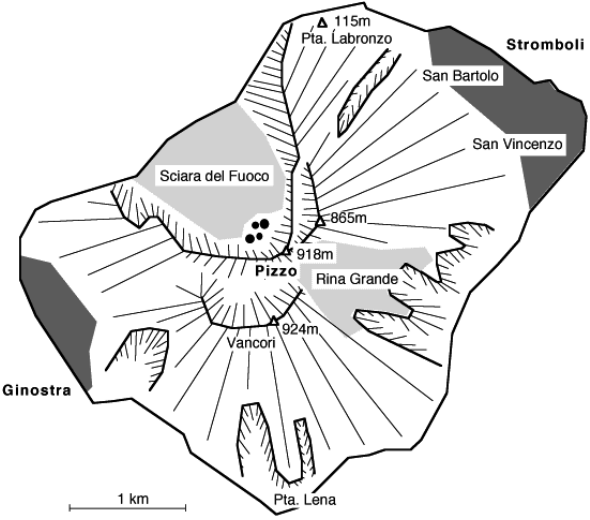
Fig. 1. Map of Stromboli volcano (Italy), where the vents are indicated by black dots (from http://www.swisseduc.ch/stromboli/